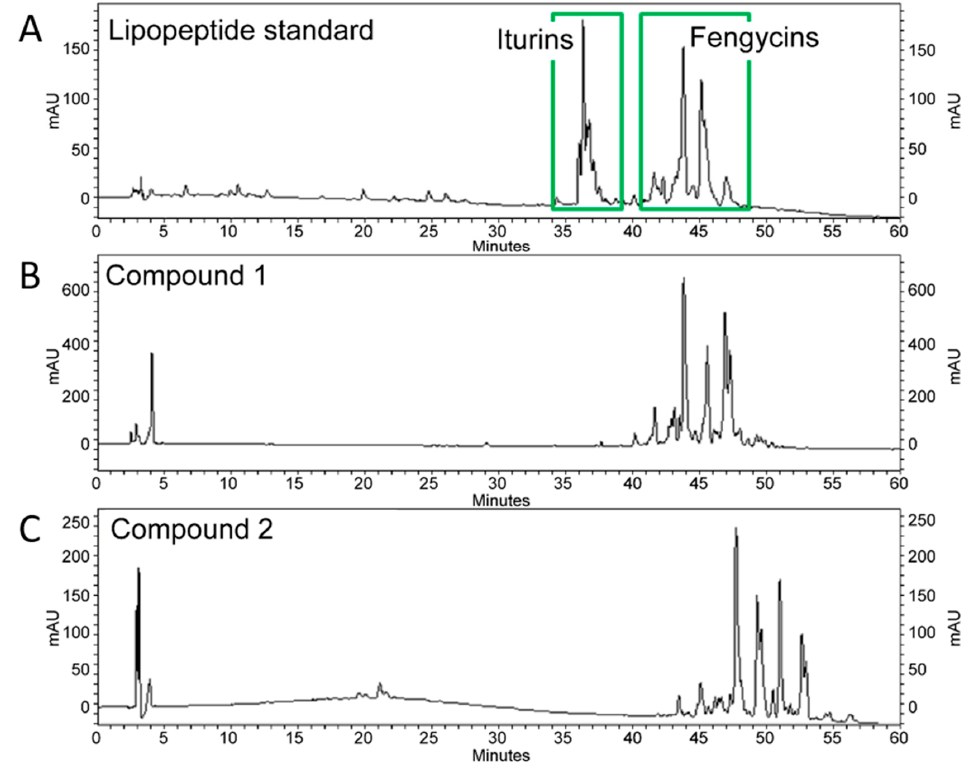
Figure 2. HPLC chromatograms showing inhibiting substances compounds 1 ( B ) and 2 ( C ) extracted from the Bacillus subtilis SA-15 strain. The retention time of inturins and fengycins on the lipopeptide standard chromatogram ( A ) were 37–39 min and 41–49 min, respectively.